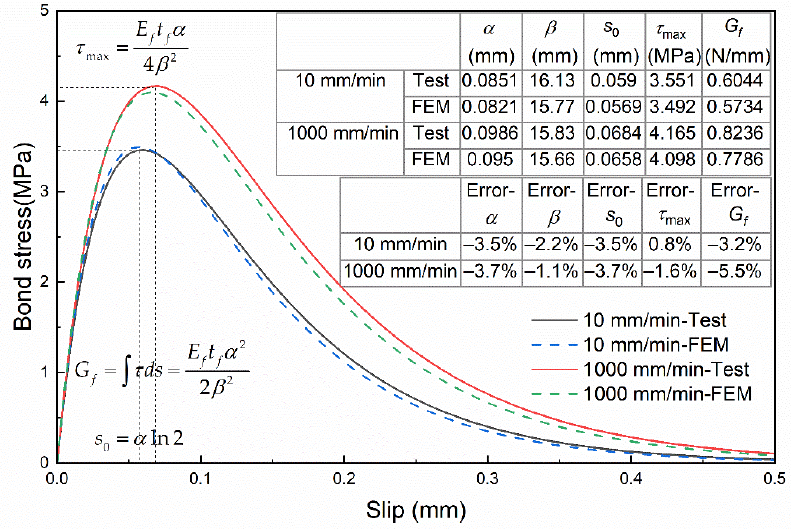
Figure 14. Comparison of bond–slip curves between numerical and test.